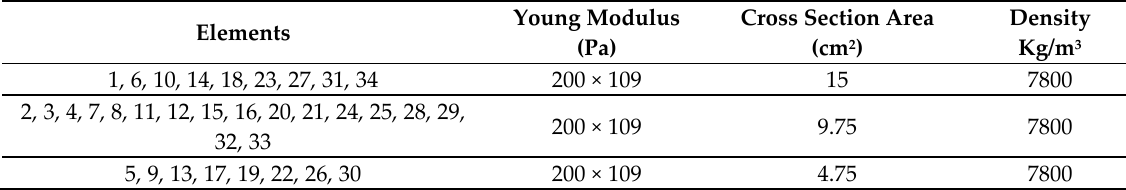
Figure 4. The model of the truss used for simulation—Blue italic numbers show the member number and the black ones indicate the node numbers. There are eighteen nodes and 34 members; Red bold arrows show where the simultaneous excitations are applied. Table 1. Properties of the truss